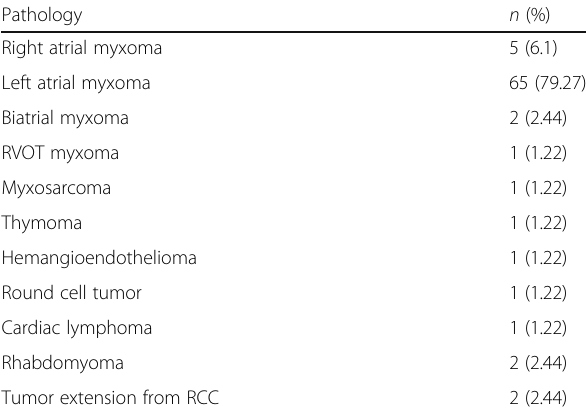
Table 3 Pathological diagnoses of the studied patients Pathology n (%) Right atrial myxoma 5 (6.1) Left atrial myxoma 65